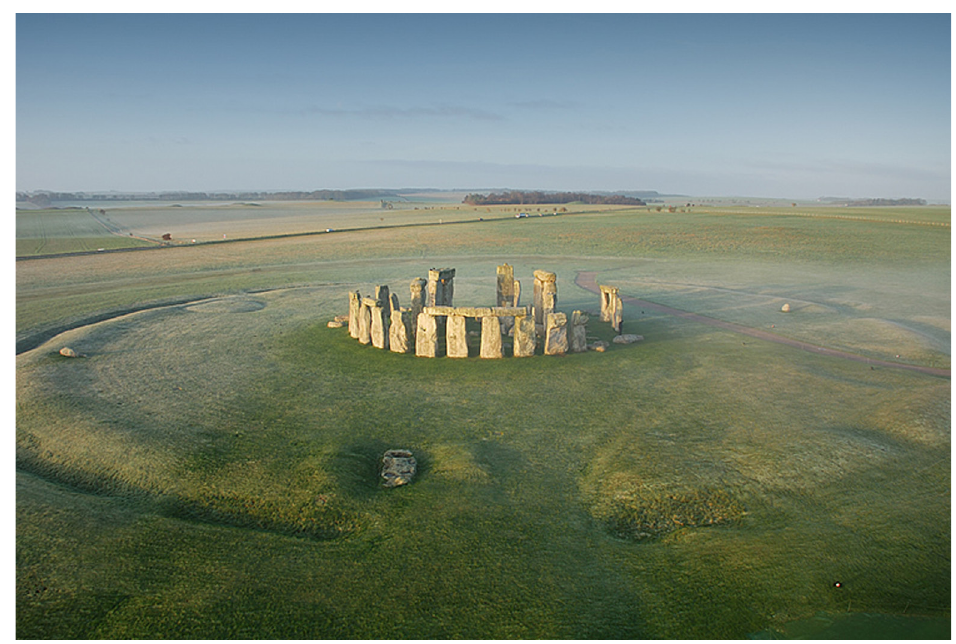
Fig. 3: Stonehenge from the air (photo: Adam